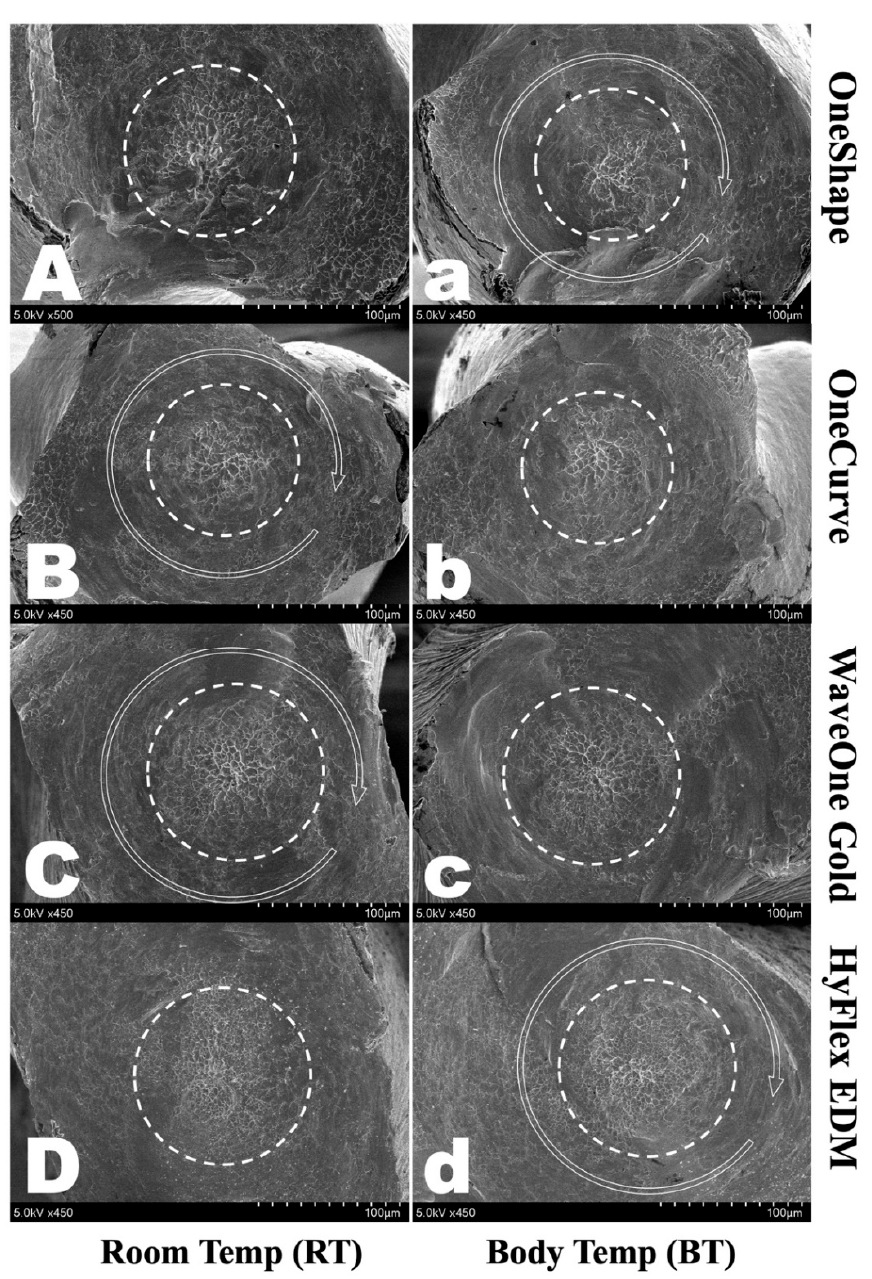
Figure 3. Scanning electron micrographs of the fracture surface of fractured segments after the torsional test. All showed typical features of torsional fractures, including concentric abrasion marks ( round arrow ) and fibrous dimples ( dotted circle ). OneShape (OS) ( A ) RT and ( a ) BT, OneCurve (OC) ( B ) RT and ( b ) BT, WaveOne Gold (WOG) ( C ) RT and ( c ) BT, HyFlex EDM (HFE) ( D ) RT and ( d )